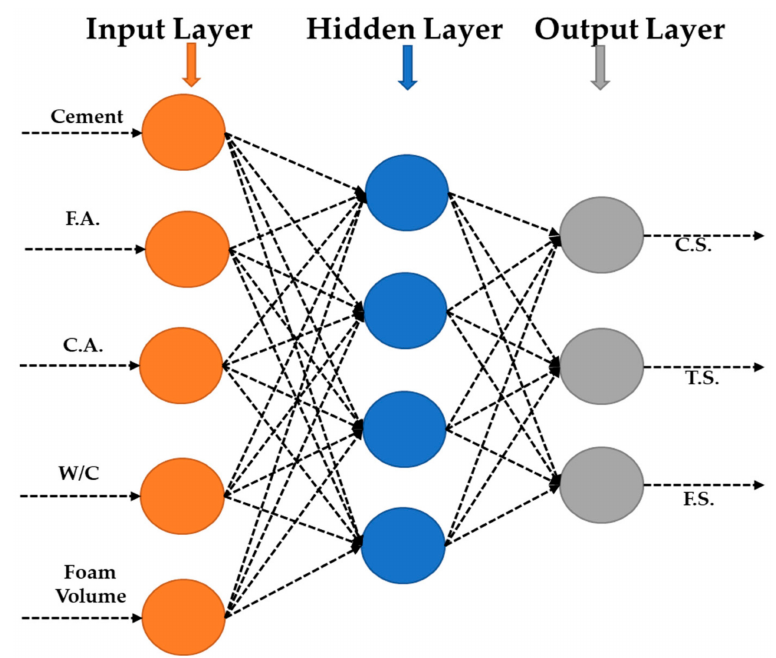
Figure 5. Artificial Neural Network